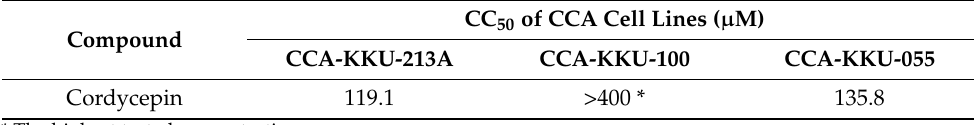
Table 1. Cytotoxicity results of cordycepin on CCA cell lines.